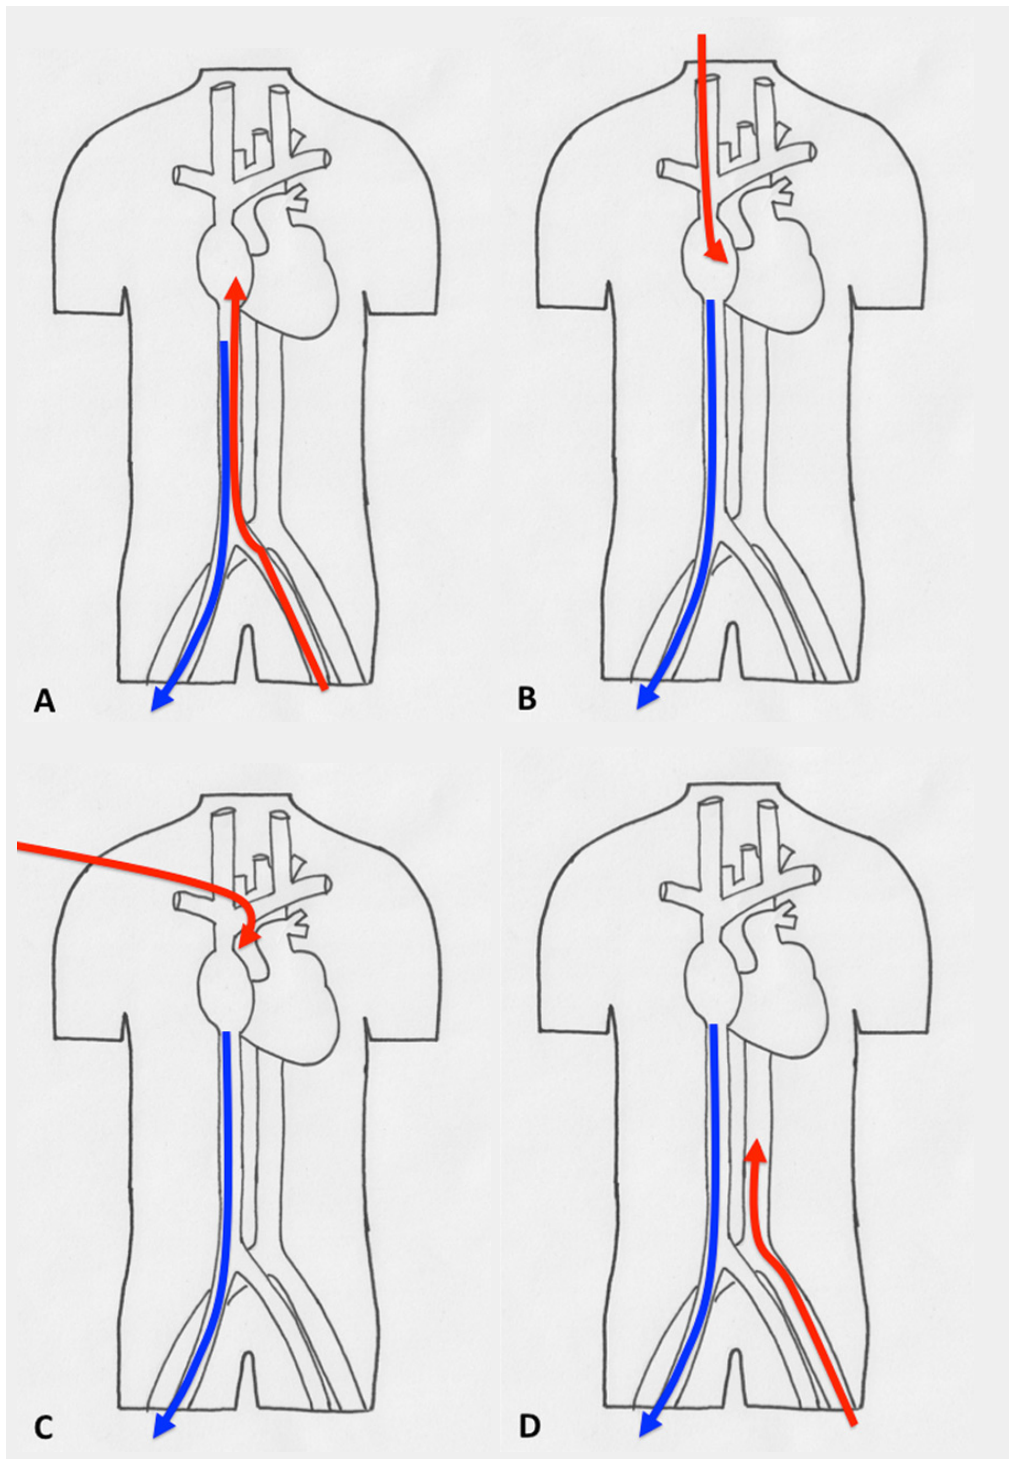
Figure 2 Different types of cannulation for venovenous and venoarterial cannulation. (A) Femorofemoral venovenous extracorporeal life support (VV ECLS) cannulation modality, with drainage cannula just underneath of the junction between the inferior vena cava and right atrium. The inflow cannula is positioned in the right atrium. (B) Venoatrial VV ECLS cannulation modality, where the drainage cannula is positioned just underneath the right atrium. The inflow cannula is placed via the internal jugular vein with its tip just in front of the tricuspid valve. (C) Standard central cannulation for ECLS, here the drainage device is depicted positioned in the femoral vein. Of note is that from the aspect of support this does not show any difference compared with the device being in right atrium. (D) Femorofemoral AV ECLS cannulation modality, with drainage device in the inferior vena cava and the inflow cannula in contralateral femoral